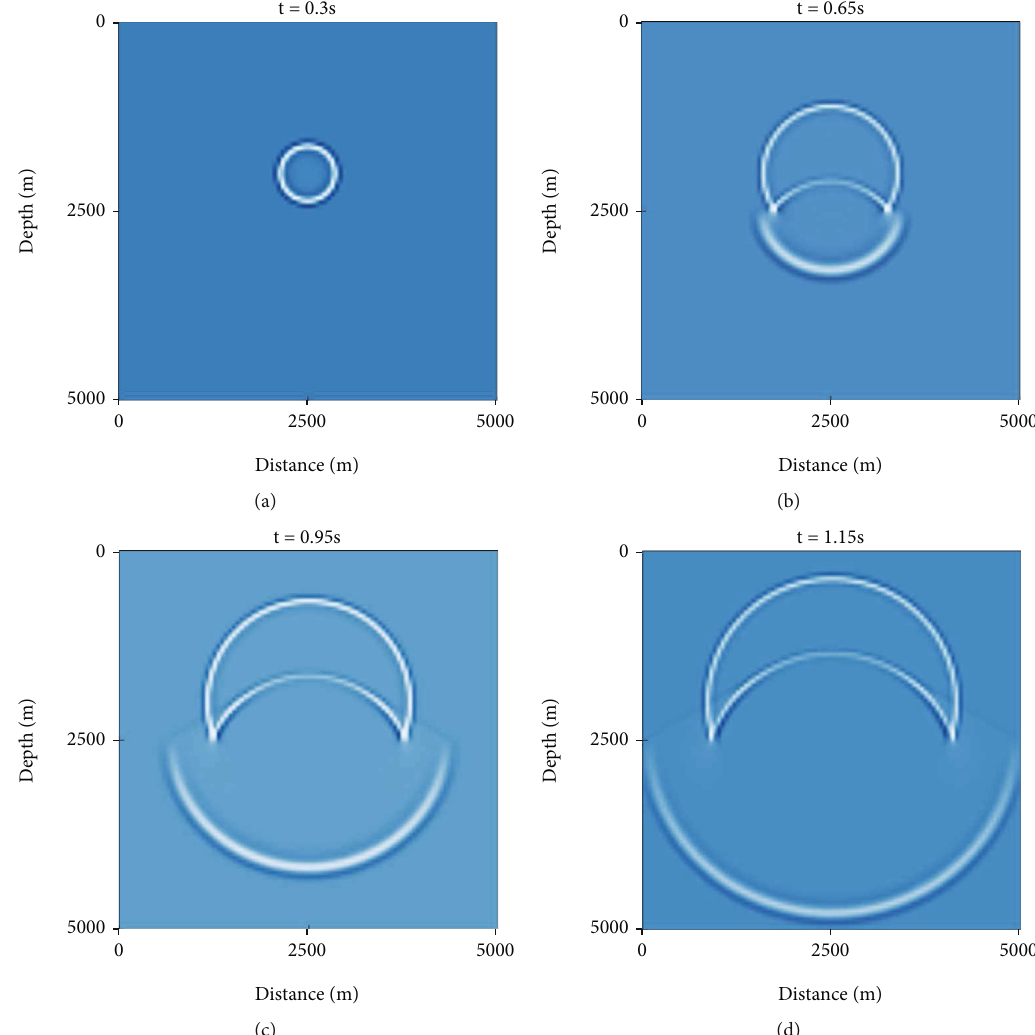
Figure 3: Wave fi eld snapshots: (a) t = 0 : 3s ; (b) t = 0 : 65s ; (c) t = 0 : 95s ; (d) t = 1 : 15s